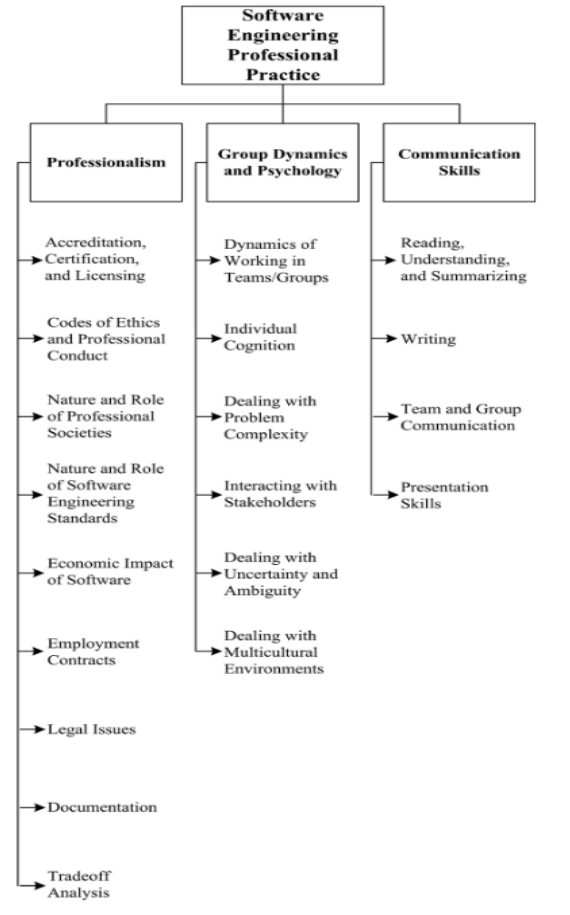
Figure 1. Non-technical skills in SWEBOK